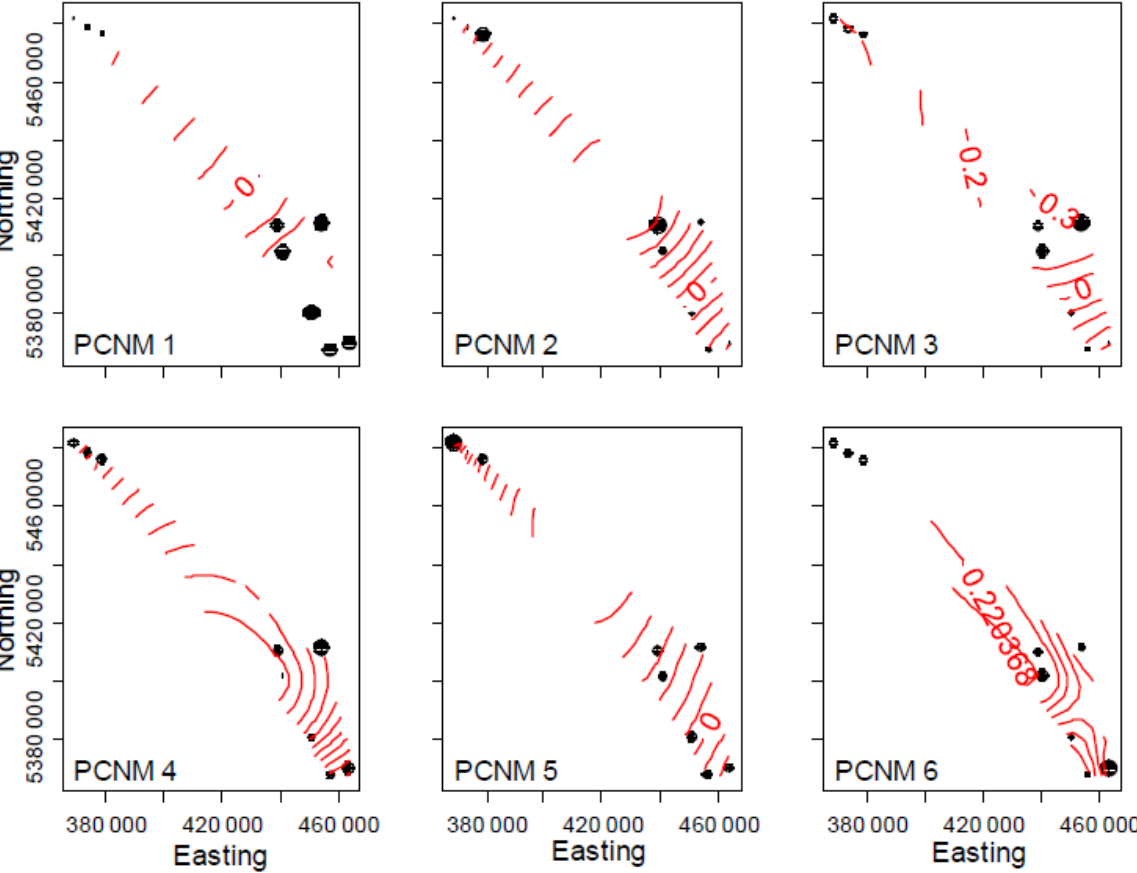
Figure 4. Principal components of neighbor matrices (PCNMs) of spatial layout of field sites. PCNMs 1, 3, 4, 5 and 6 were significantly associated with microbial composition, while PCNMs 1, 2, 3, 4 and 5 were significantly associated with community structure. Point size is proportional to PCNM values for each sampling location.